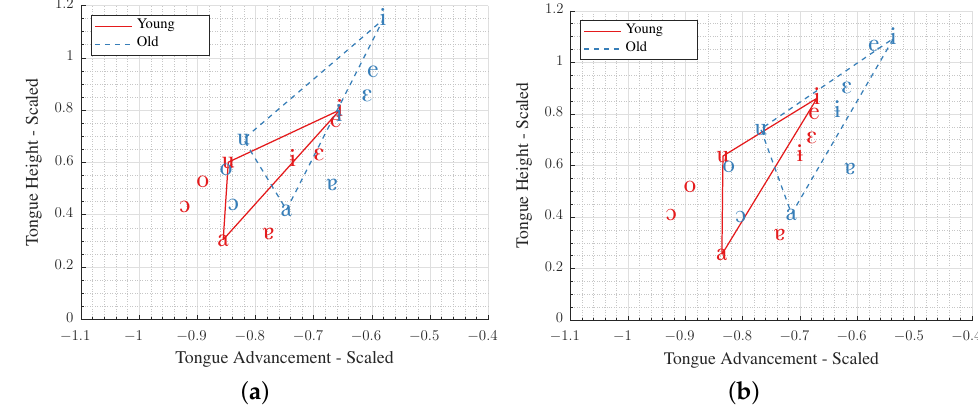
Figure 9. Articulatory vowel space of the EP cardinal vowels in pVCv ( a ) and in isolated context ( b ) by age group. The remaining vowels are also